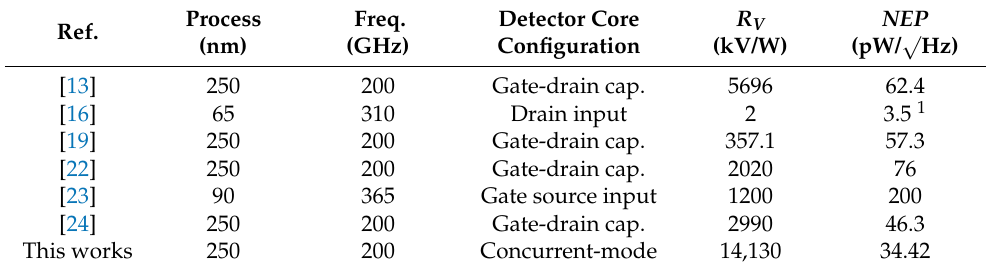
Figure 10. Measurement results of the voltage responsivity and the noise-equivalent power using the proposed CMOS detector IC at 200 GHz. Table 1. Comparisons of CMOS detector